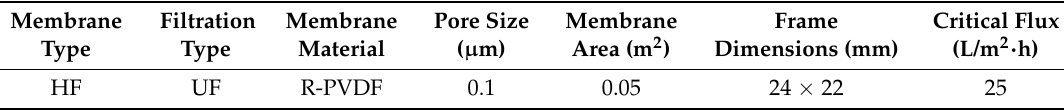
Table 1. HF Membrane Characteristics.